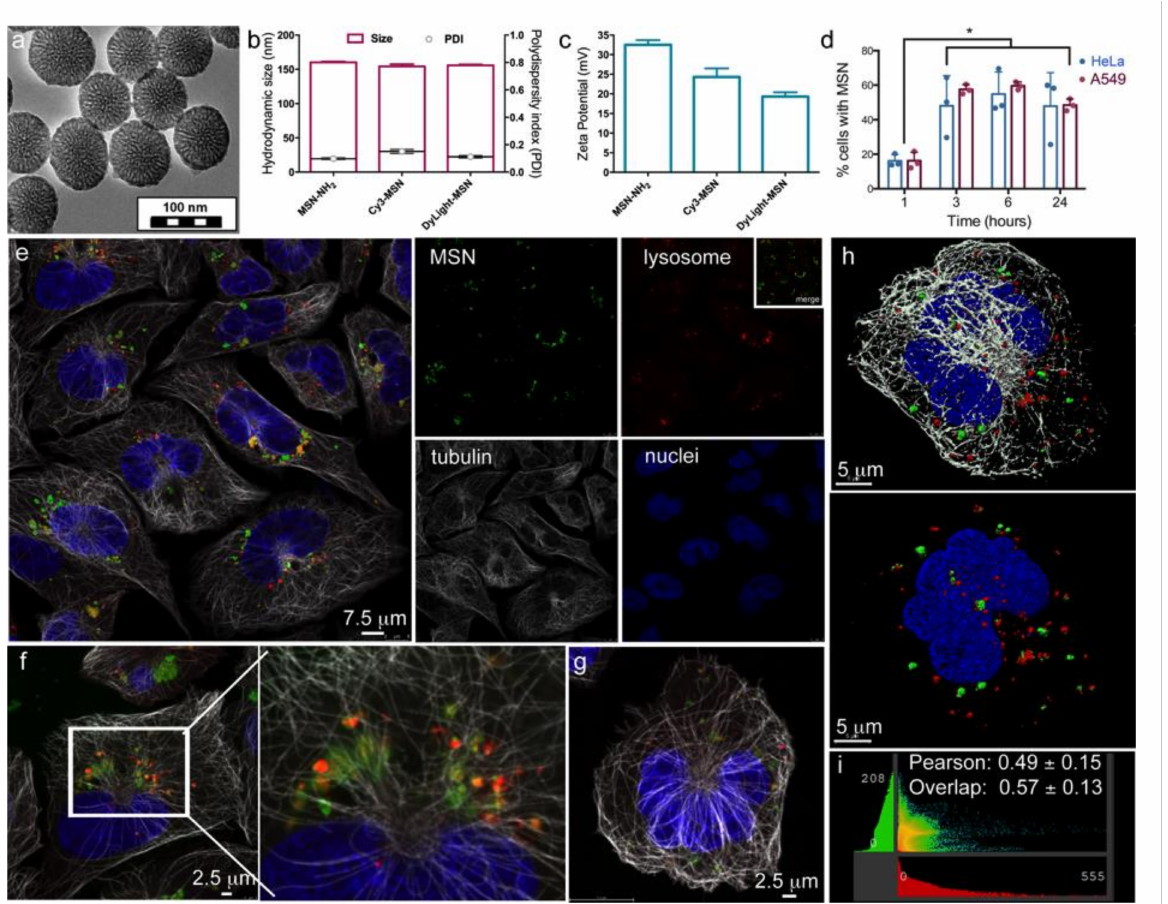
Figure 1. Endolysosomal localization of internalized MSN. ( a ) Transmission electron micrograph of MSN showing size and porous structure. ( b ) Dynamic light scattering analysis of hydrodynamic size and polydispersity (in water). ( c ) Zeta potential measurements before and after fluorophore grafting. ( d ) Flow cytometry analysis of MSN internalization from 1 to 24 h in HeLa or A549 cells. Merged ( e – h ) or single ( e ) fluorophore confocal micrographs of LysoTracker™ Red (red), AF488 anti- α -tubulin antibody (white), and DAPI (blue) labeled HeLa cells following 24 h incubation with DyLight™ 633-labeled MSN (green). The 2D ( f ) and 3D ( g ) projection images, with surface rendering in ( h ). ( i ) Representative MSN and lysosome colocalization graph and mean Pearson’s correlation coefficient and overlap. * p <